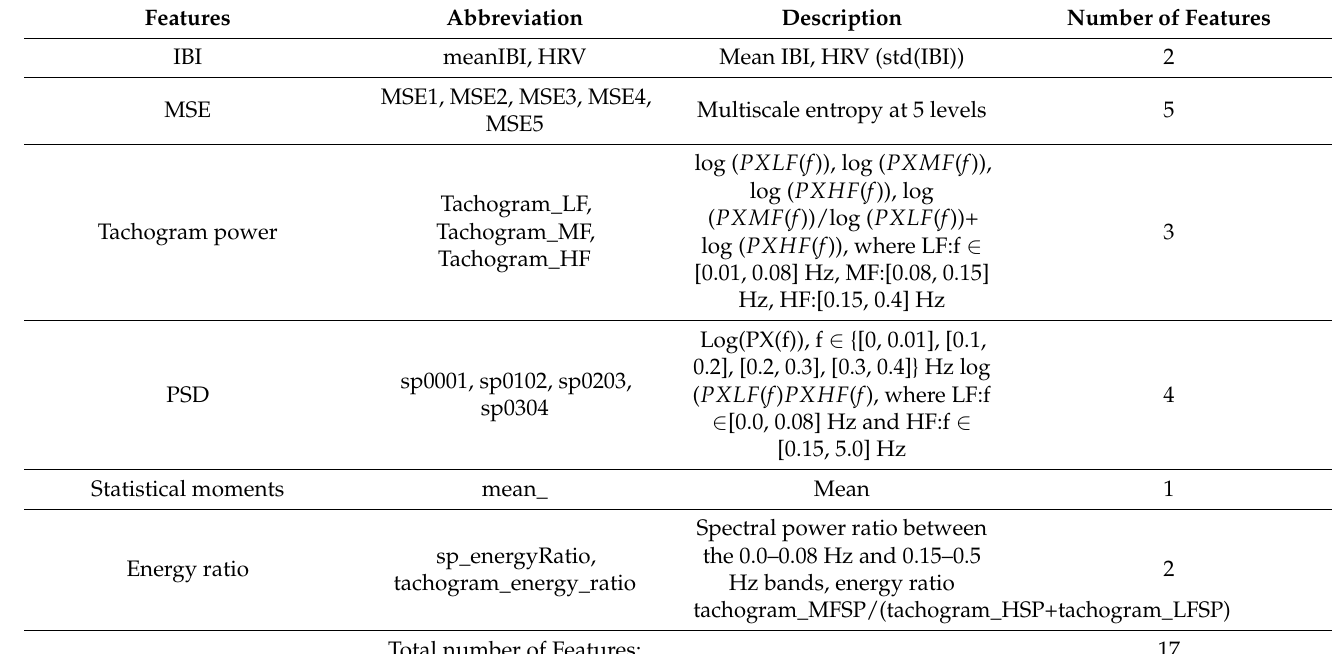
Table 4. PG features extracted using